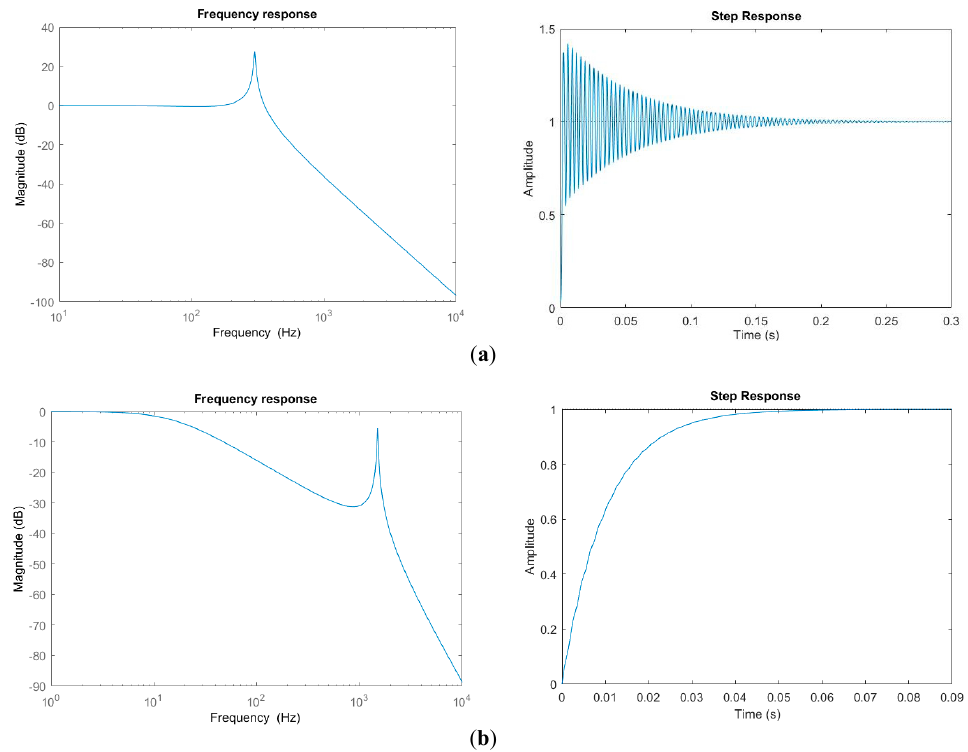
Figure 4. Frequency response and step responses of the whole system with ( a ) Q = 50, (cid:2028) = 1 ms and (cid:1858) (cid:2868) = 300 Hz; ( b ) Q = 50, (cid:2028) = 10 ms and (cid:1858) (cid:2868) = 1,500